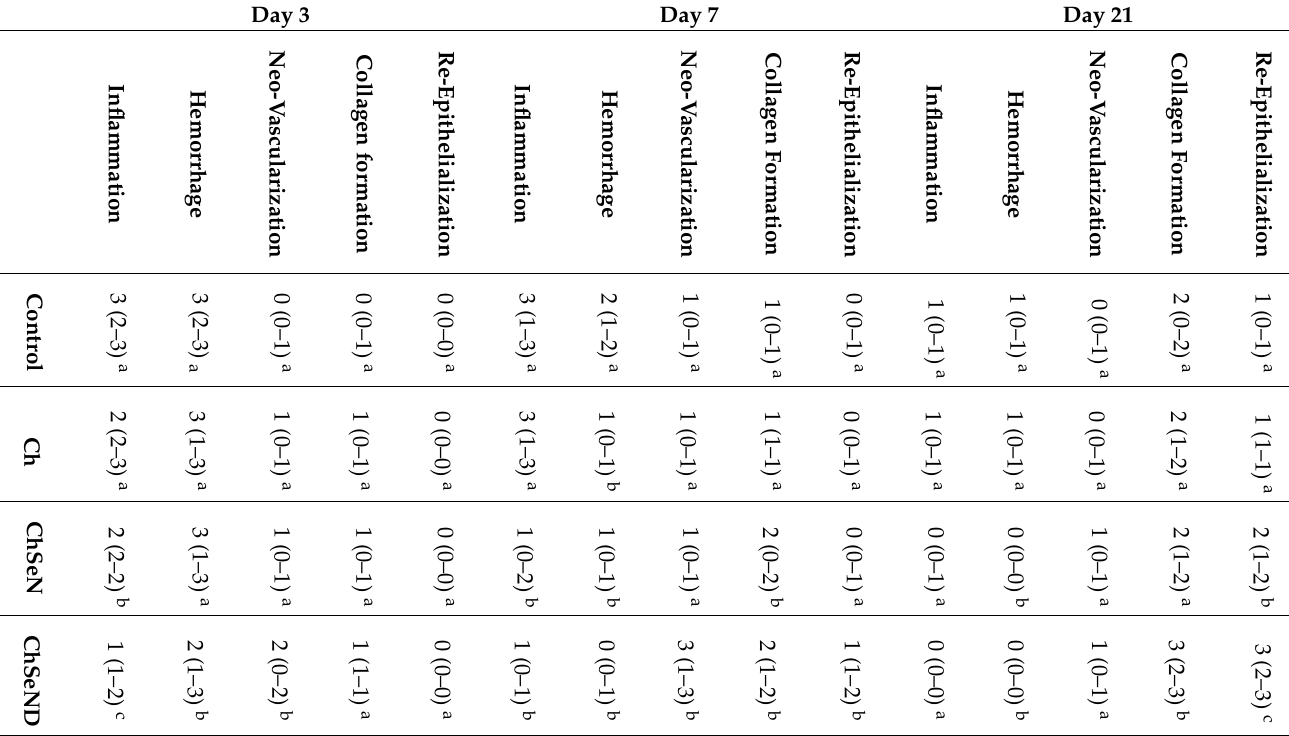
Table 4. Comparison of the median of various tissue parameters between different groups.